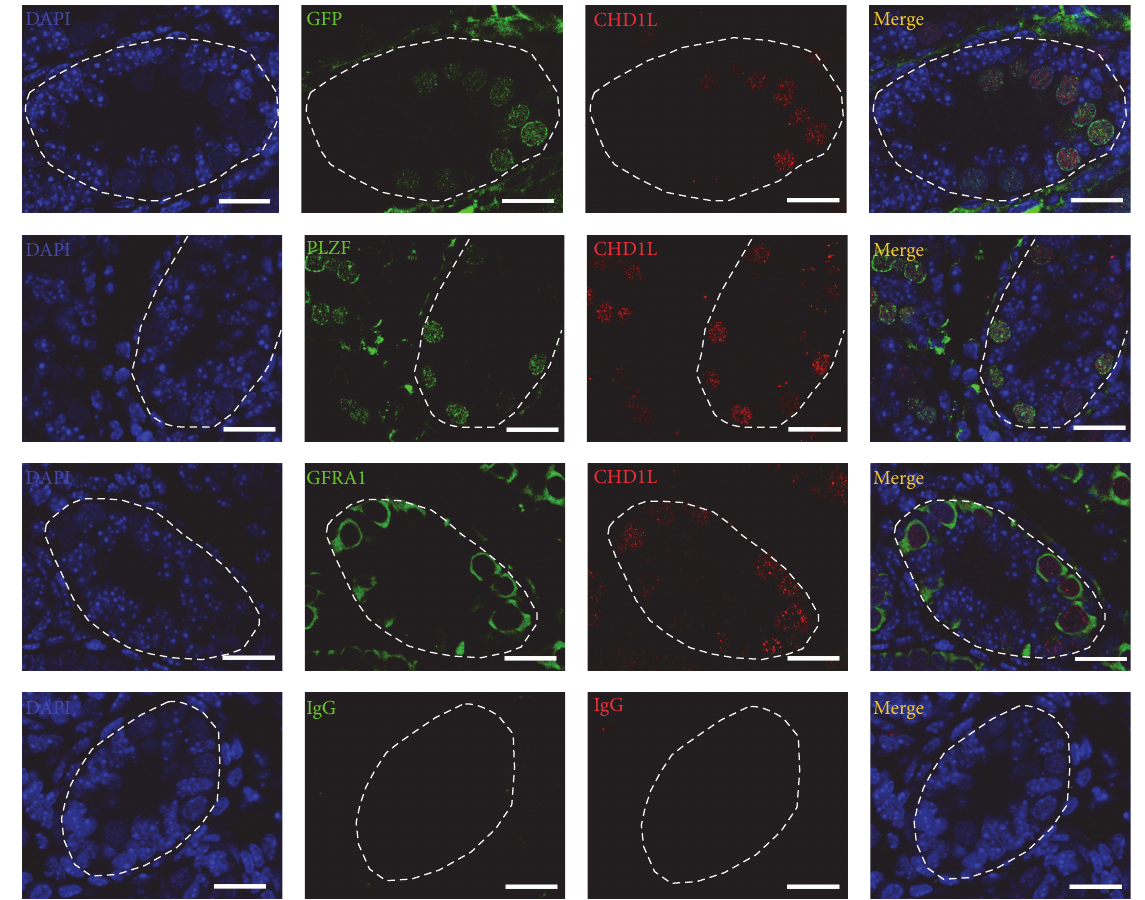
Figure 2: CHD1L is coexpressed with other SSC markers in undifferentiated spermatogonia cells. Immunofluorescence staining of mouse testicular tissues harvested at 5 dpp, sectioned, and subjected to immunofluorescence staining with antibodies against CHD1L (red), PLZF (green), GFR Α 1 (green), or GFP (green), respectively. The nuclei were visualized with DAPI (blue). The right panels are the merged images showing coexpression of CHD1L with PLZF, GFR Α 1, or GFP in most undifferentiated spermatogonia at 5dpp. Normal goat or rabbit IgG were applied as negative controls (bottom row). Representative images from three animals ( 𝑛 = 3 ) were presented here. Scale bars represent 50 𝜇 m. SSC: spermatogonial stem cell; dpp: days postpartum; PLZF: promyelocytic leukemia zinc finger; GFR Α 1: GDNF-family receptor 𝛼 -1; DAPI: 4 󸀠